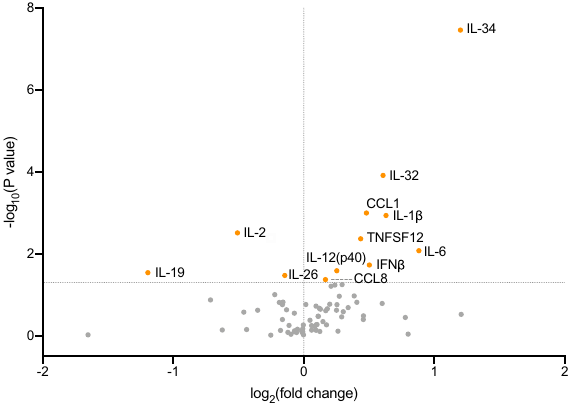
Figure 4. Volcano plot displaying biomarkers with a significant p- value (y axis) and fold change (relapse/ non-relapse, x axis) between relapsed and non-relapsed groups at study initiation. The horizontal dotted line indicates where p = 0.05. Biomarkers with p value of < 0.05 are shown by orange dots. The serum concentration of the analyte was measured in each patient at time points A and F in the sustained remission group and at time points B and C in the relapse group (Fig. 1). The image was created using GraphPad Prism 8 (http:// www. graph pad. com).